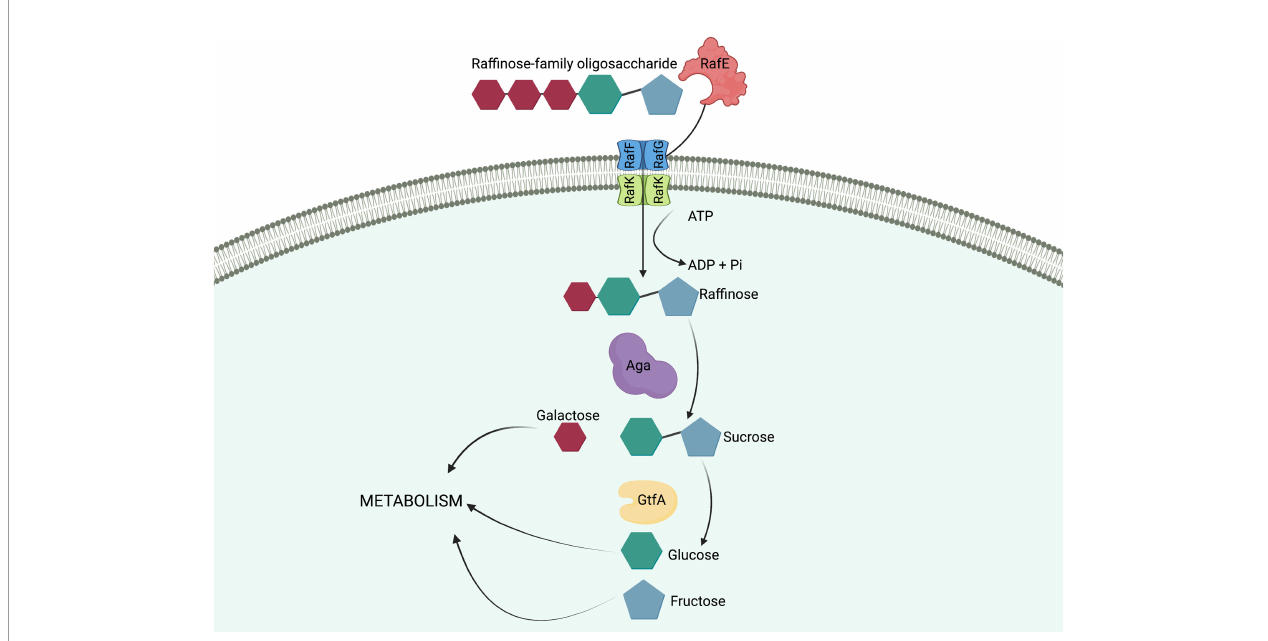
FIGURE 3 | Import and breakdown of raf fi nose in S. pneumoniae. A raf fi nose-family oligosaccharide (RFO) is delivered to the ABC transporter cell membrane components, RafF and RafG, by the solute-binding protein, RafE. The RFO is imported into the cell using the energy produced from the ATP-binding protein, RafK, with concomitant ATP hydrolysis. In the cytoplasm of the cell raf fi nose is sequentially degalactosylated by an a -galactosidase, Aga, releasing galactose, which can enter other metabolic pathways, and sucrose. A sucrose phosphorylase, GtfA, cleaves sucrose into glucose and fructose, both of which can enter further metabolic pathways and be utilized by the cell. (Hobbs et al., 2019). Created with BioRender.com.